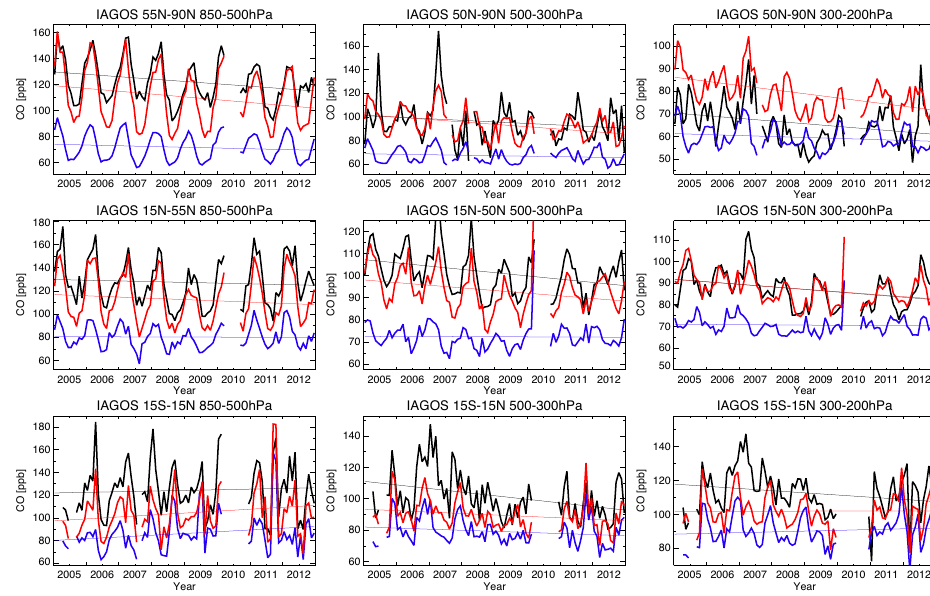
Figure 12. Same as in Fig. 8, but for CO concentration obtained from MOZAIC/IAGOS aircraft